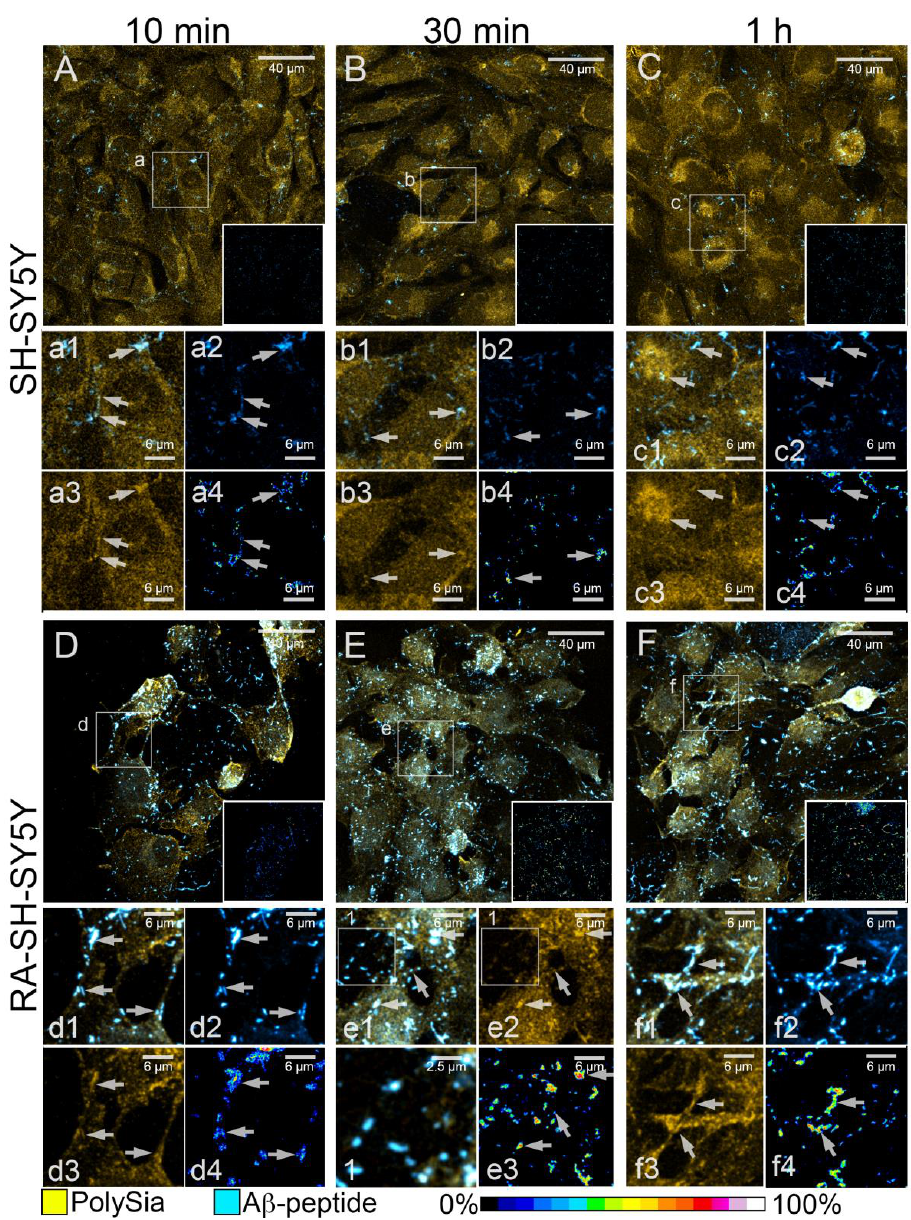
Figure 6. PolySia and A β -42 amyloid in SH-SY5Y and RA-SH-SY5Y cells. ( A – F ) Representative images of SH-SY5Y ( A – C ) and RA-SH-SY5Y ( D – F ) cells stained to reveal PolySia (Yellow) after 10 min ( A , D ), 30 min ( B , E ) and 1 h ( C – F ) of incubation with A β species (Cyan); square areas in lower right corners show the efficiency of FRET interactions (corresponding full-size images are shown in Supplementary Figure S2). Insets ( a – f ) show details of the areas selected in images ( A – F ): images of merged channels ( a1 – f1 ), A β -42 immunofluorescence ( a2 – d2 , f2 ), PolySia staining ( a3 – d3 , e2 , f3 ) and FRET efficiency ( a4 – d4 , e3 , f4 ) are shown. Arrows in ( a – c ) indicate sites of high FRET efficiency between amyloid species and PolySia on cell bodies. Arrows in ( d – f ) indicate sites of binding between A β -42 and PolySia on cytoplasmic projections. Inset 1 shows details of the area shown in ( e1 , e2 ); merged fluorescent signals and PolySia staining alone are